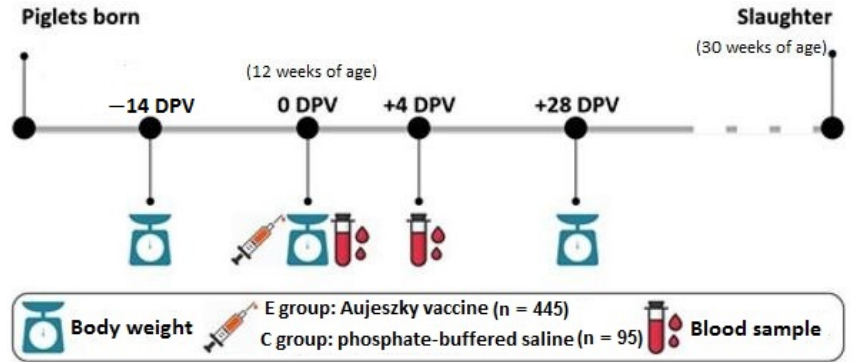
Figure 1. Timeline and experimental design.